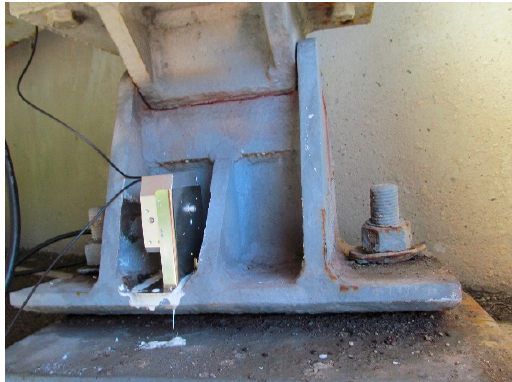
Figure 3. FBG tiltmeter.